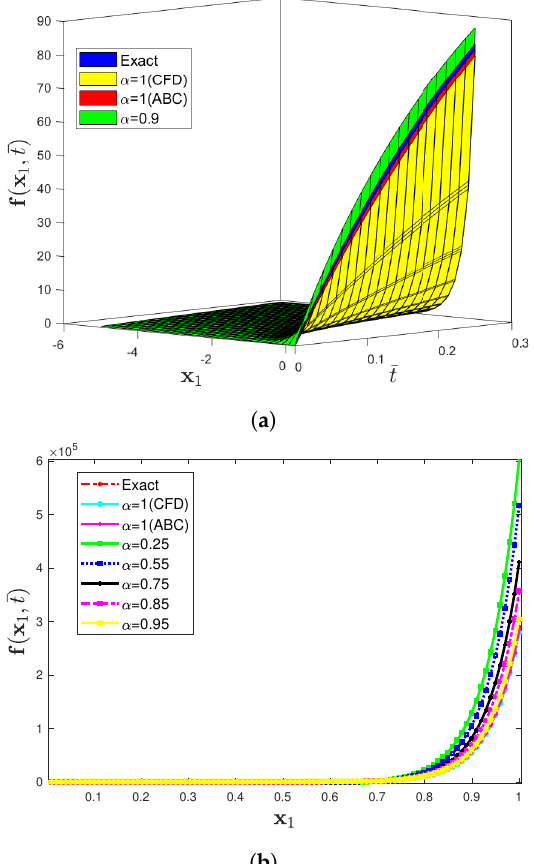
Figure 9. ( a ) Three-dimensional comparison plot among exact, CFD, and ABC fractional derivative operators via the IETM. ( b ) Two dimensional representation of f ( x 1 , ¯ t ) for Problem 3 at different fractional orders when θ = 1, β = 6, and ϕ =